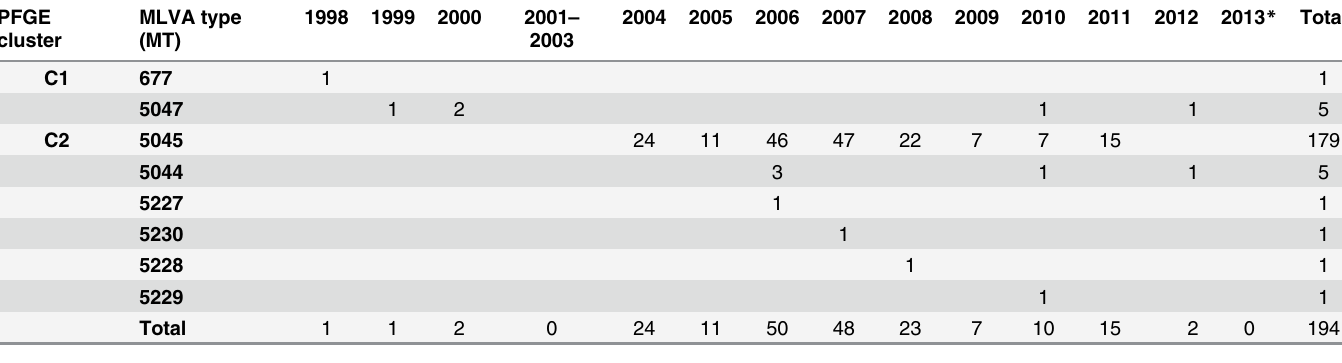
Table 1. Distribution of ST8-MRSA-IV-t304-PVL-negative isolates from 1998 – 2013 according to PFGE and MLVA analyses. PFGE MLVA type cluster